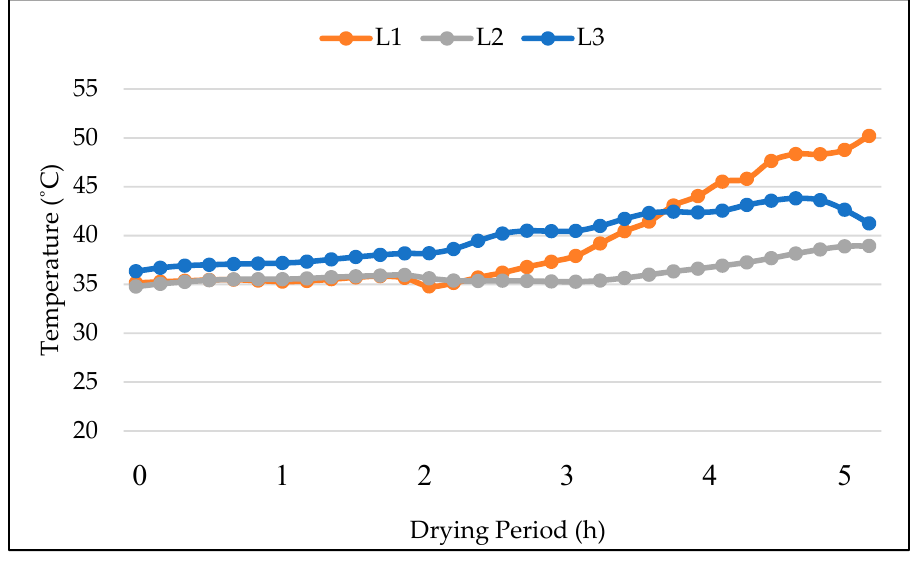
Figure 6. Temperature variations at L1, L2, and L3 in the drying chamber.